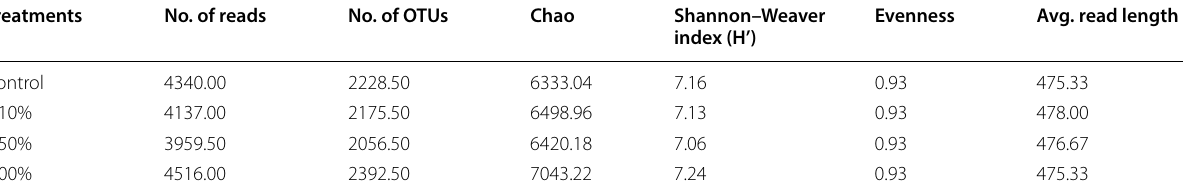
OTU operational taxonomic units OTUs were calculated by the RDP pipeline with a 97% OTU cut-off of the 16S rRNA gene sequences. Diversity indices of the microbial communities and numbers of phyla and genera were calculated using the RDP pyrosequencing pipeline based on the 16S rRNA gene sequences